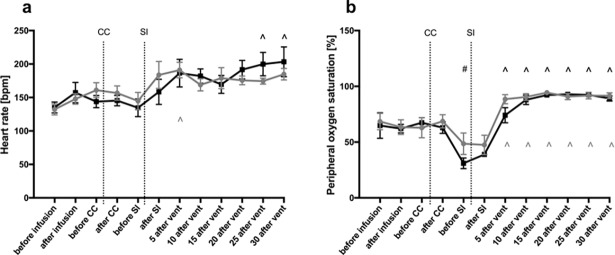
Heart rate (a) and peripheral oxygen saturation (b) in caffeine treated (grey dots) and control (black squares) lambs. The figure shows mean± SEM values at different time points during the experiment: before caffeine/ saline infusion; after caffeine/ saline infusion; before cord clamping (CC); after CC; before sustained inflation (SI); after SI; 5, 10, 15, 20, 25 and 30 minutes after ventilation onset. # indicates significant difference compared to “before CC” (grey within caffeine group, black within saline group). ^ indicates significant difference compared to “before SI” (grey within caffeine group, black within saline group).